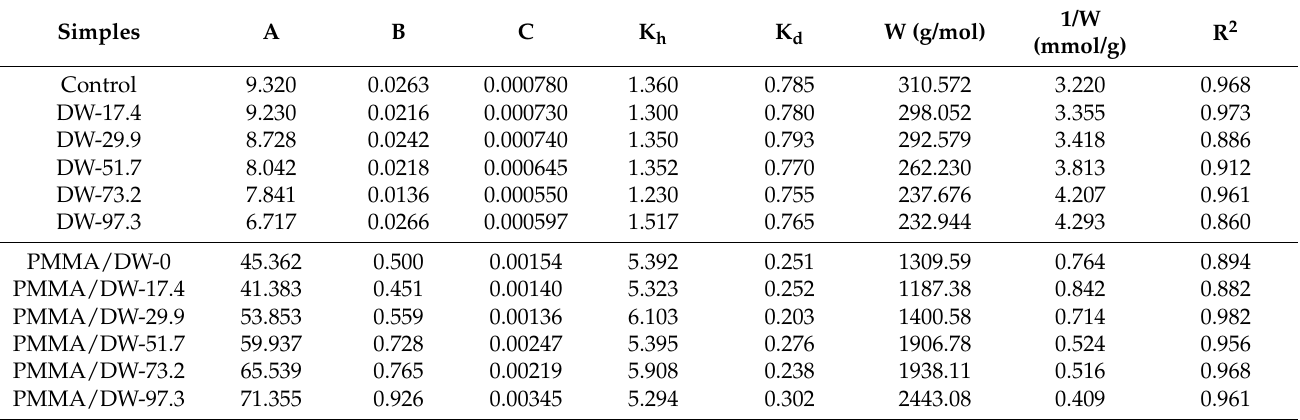
Table 3. Fitted and physical constants calculated for the Hailwood–Horrobin adsorption isotherms